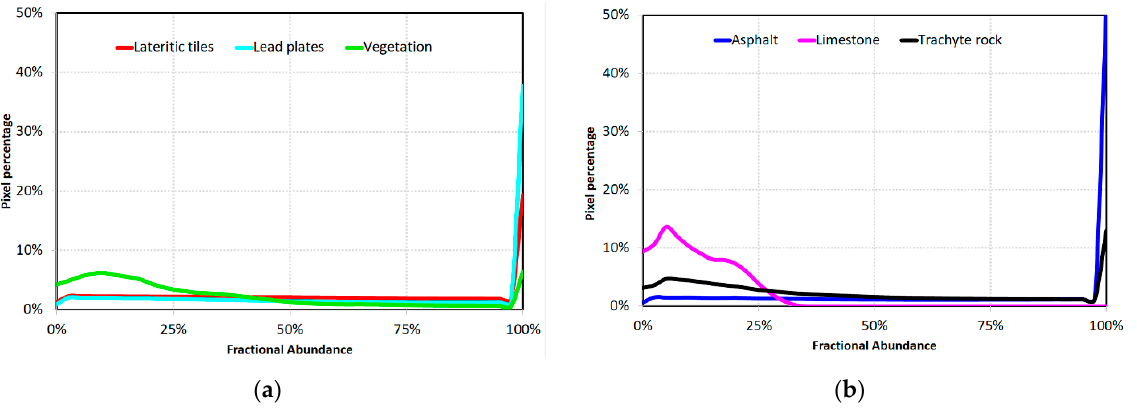
Figure 8. FAMs: ( a ) FAMs of Lateritic tiles, Lead plates, and Vegetation; ( b ) FAM of Asphalt, Limestone, and Trachyte rock.